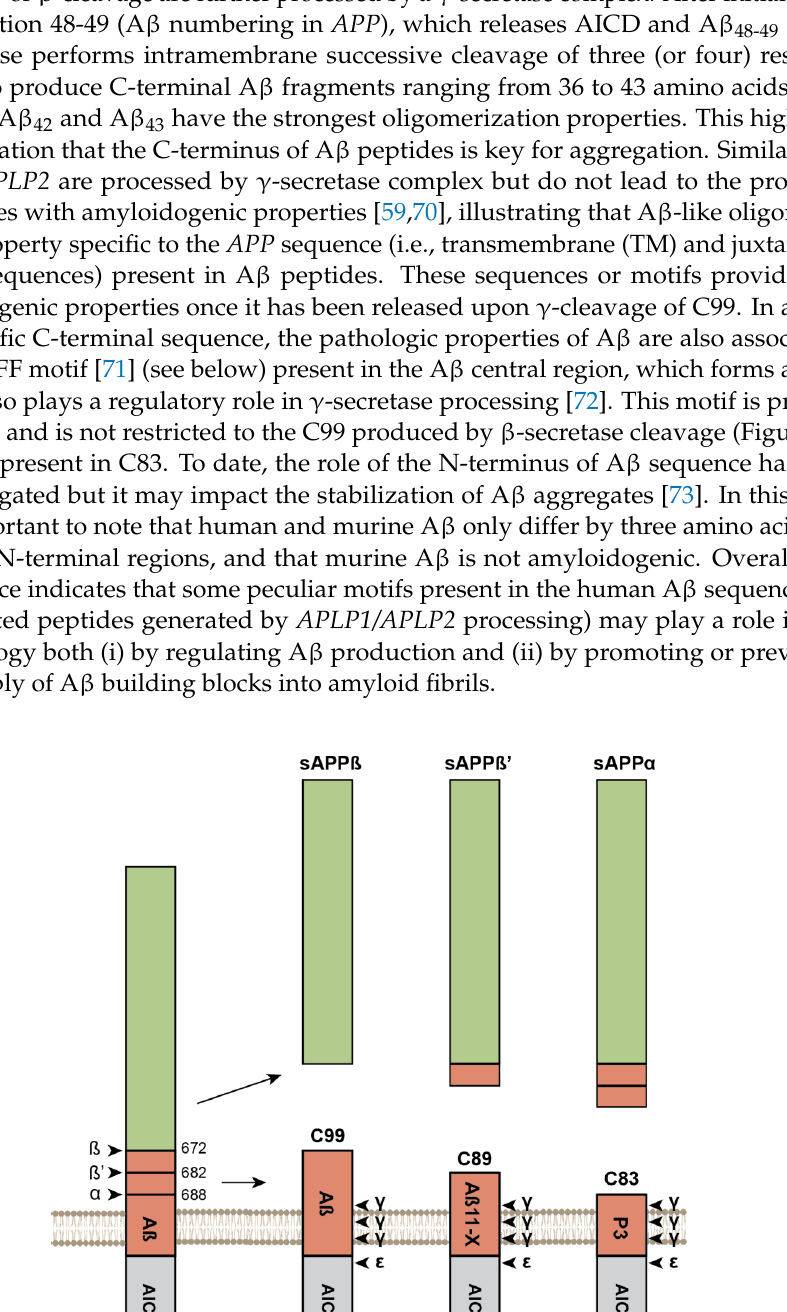
Figure 2. Processing of the APP protein family. ( A ). Illustration of APP processing. The sites of α , β , and β’ cleavage are shown with amino acids corresponding to cleavage position. Upon cleavage by α - or β -secretase, fragments called s APP α , s APP β and s APP β’ are released and secreted and C83, C89, or C99 remain embedded in the membrane, respectively. C99 contains the complete A β se- quence, while C89 and C83 have truncated (11-X and 17-X, respectively) A β sequences. The A β 17- X is also called the P3 fragment. The first cleavage by γ -secretase occurs at the ε site to release AICD prior to intramembrane proteolytic cleavage of 3 or 4 amino acids to produce amyloid β (A β ) pep- tides from 36 to 43 amino acids. ( B ). Sequence alignment of APP C99, C89, C83 and APLP1 /2 β -CTF. The alignment illustrates sequence differences between the members of the APP family. The bottom panel highlights amino acids from most conserved (yellow) to less conserved (dark brown). The LVFF motif (red) is present only in APP while the C-terminal fragment is similar between APP and APLP2 . The cleavage sites of γ -secretase are mostly conserved between all members of the APP